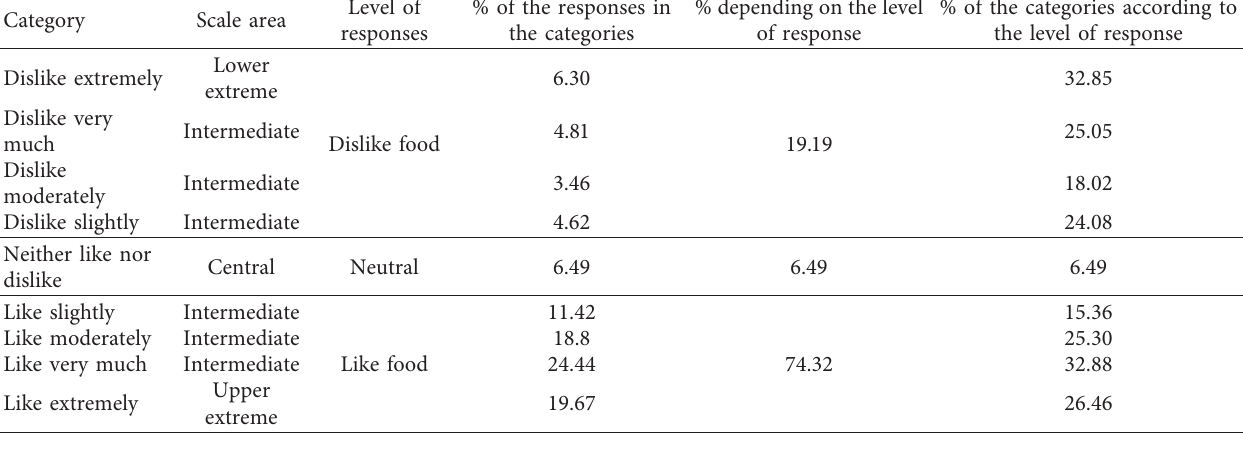
Table 7: Behavior of food preference responses.